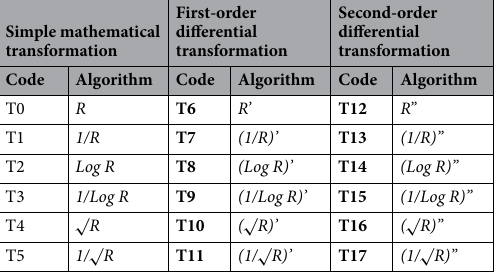
Table 1. Soil spectral preprocessing mathematical algorithms. R represents the original spectrum, the same below.